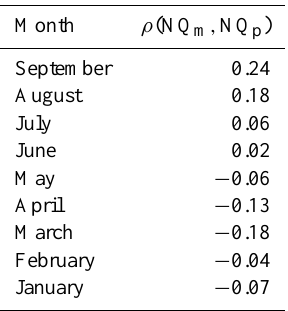
Table 1. Correlation coefficient between NQ p and NQ m for varying low flow season in the